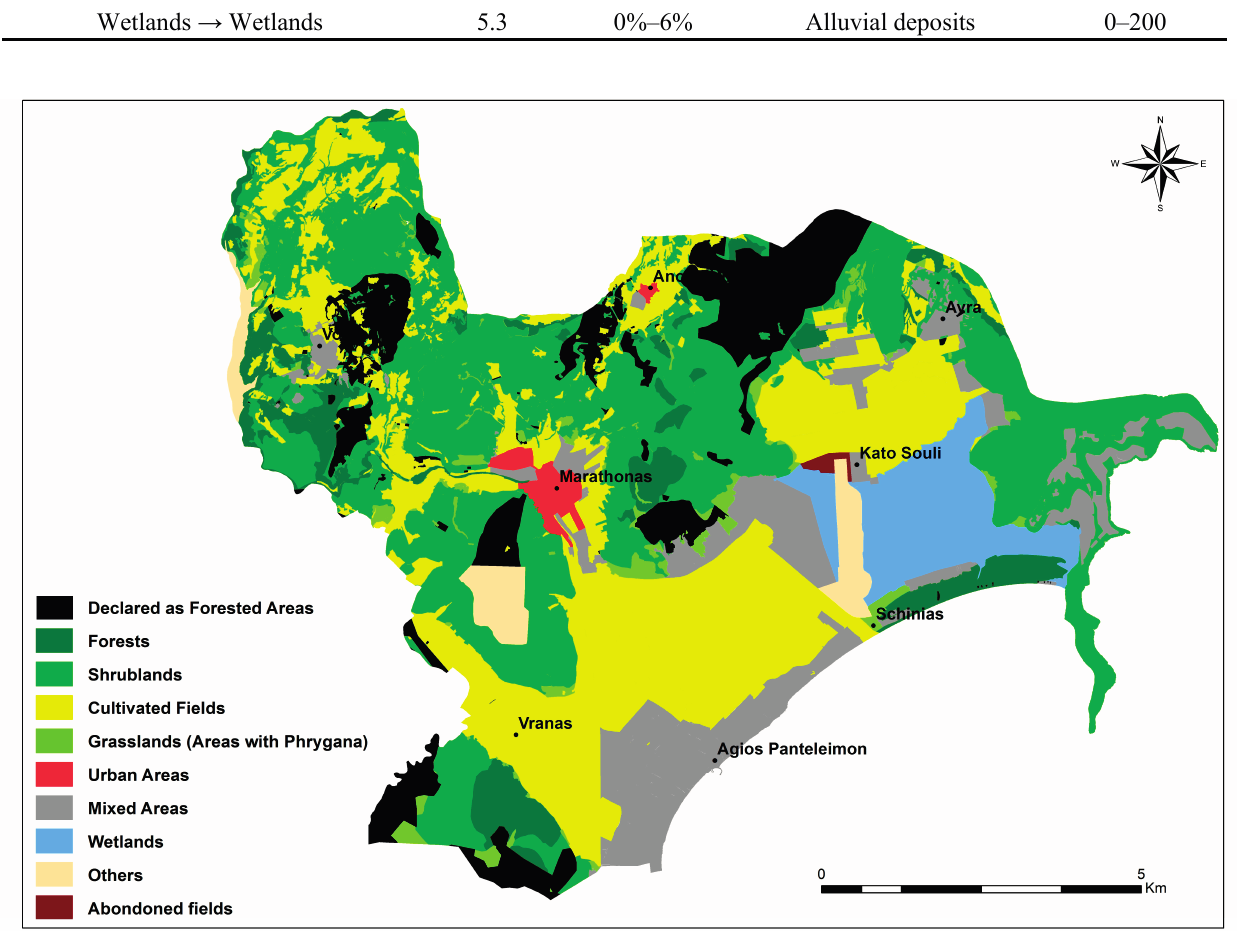
Figure 4. The burned areas (black color) are declared as forested